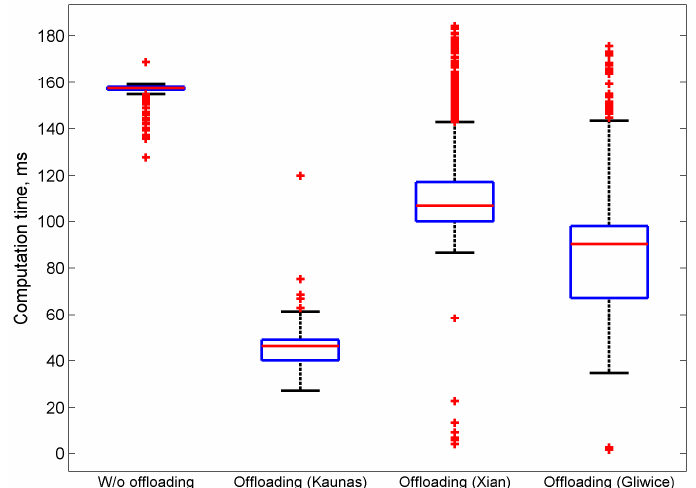
Figure 9. Performance comparison of computational offloading using local (Kaunas) and remote (Xian and Gliwice) cloud servers.